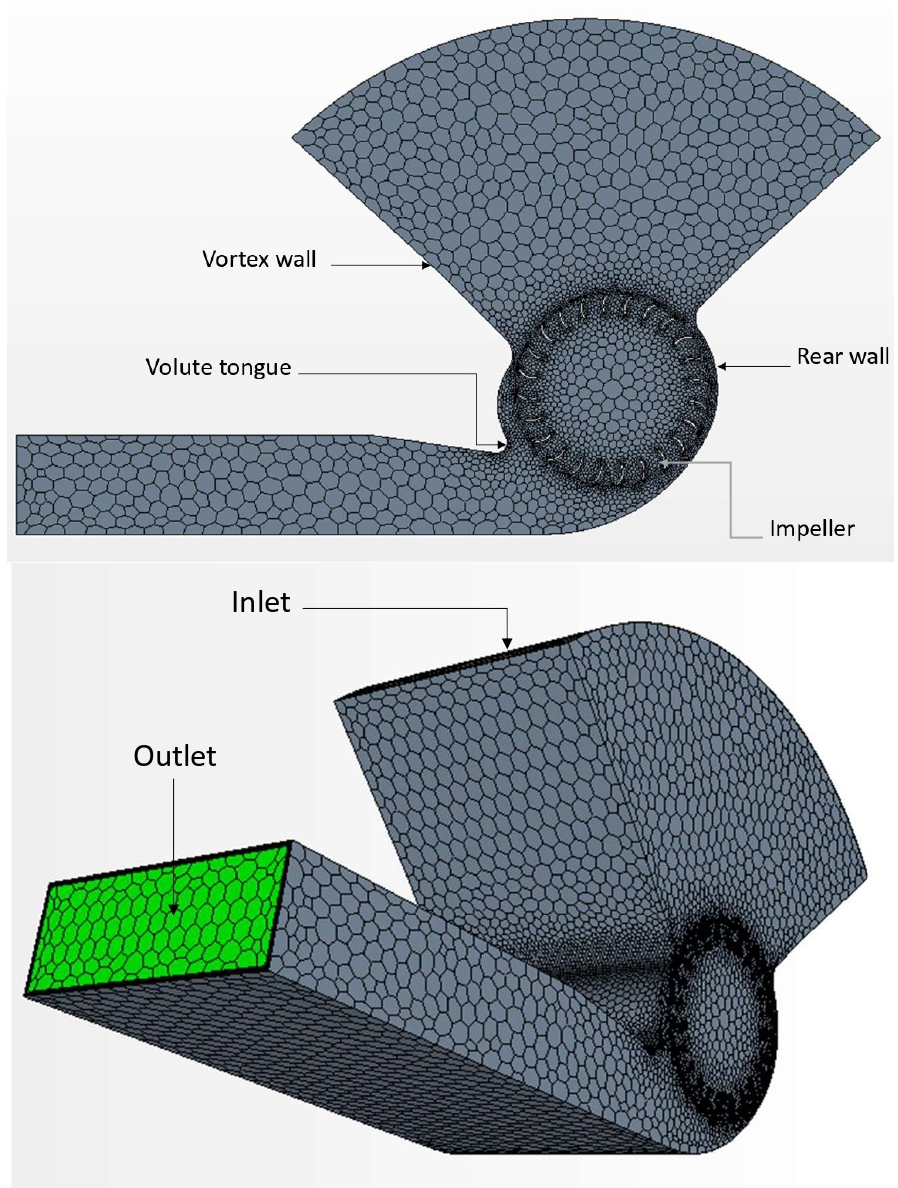
Figure 21. CFD meshing of the internal volume of the CFF. The data collected from the simulations were projected in a cross-section normal to the longitudinal axis, as shown in Figure 22. The streamlines delimit the re-circulation zone. We noticed that the vortex size became smaller whenever we increased the flow rate, and its center tended to move toward the rotor’s inner periphery. We can notice in Figures 23 and 24 that the angular position of the vortex center is almost equal to θ vor , dis (as defined in Figure 4) at low and medium flow rates. However, the center tends to move inside the vortex wall curvature at high flow